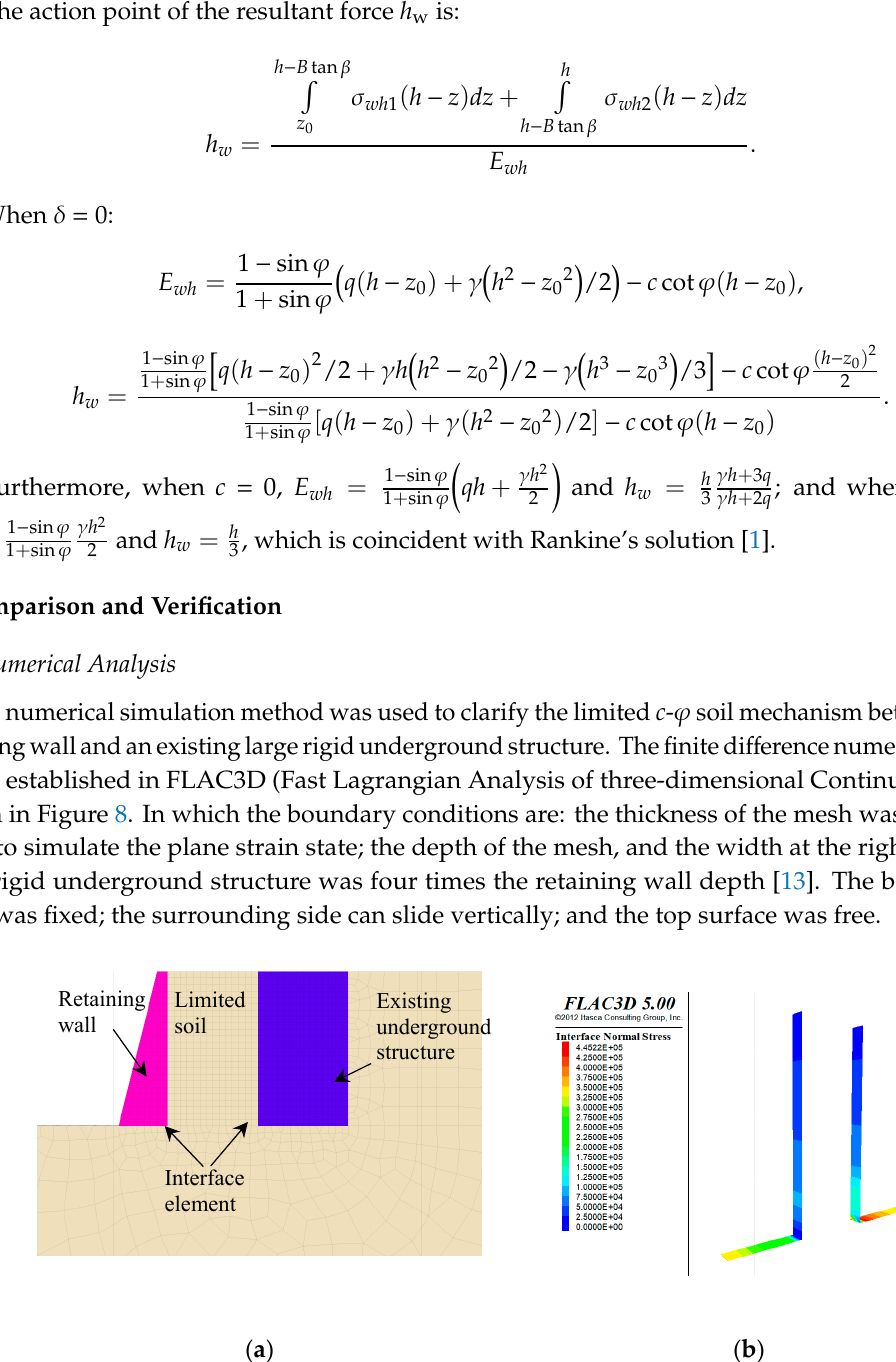
( e ) Figure 9. Displacement cloud map for c - φ soil (cohesive soil) of limited width of ( a ) 1 m; ( b) 2 m; ( c ) 4 m; ( d ) 6 m; and ( e ) 8 m.